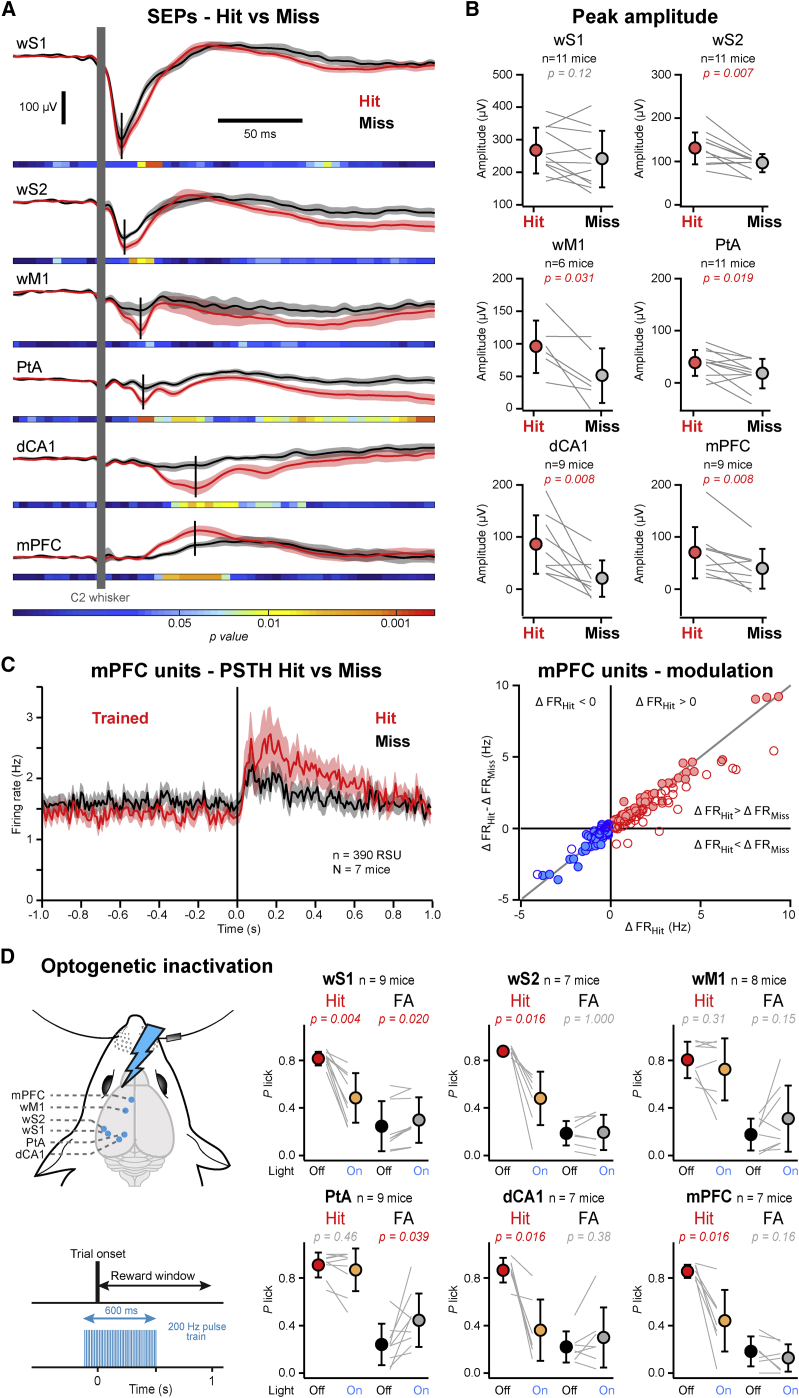
Neuronal Activity in mPFC and dCA1 Causally Contributes to Execution of the Detection Task(A) Grand average SEPs computed for Hit (red) and Miss (black) trials from mice trained in the detection task. Shaded areas indicate SEM. Horizontal bars indicate color-coded p values for statistical test of the difference between Hit and Miss trials across time (Wilcoxon signed-rank test, Hit versus Miss for 5 ms time windows). Vertical black bars indicate the times of the peak responses.(B) Comparison of the peak amplitude of the SEPs for Hit (red) and Miss (gray) trials. Circles with bars indicate mean ± SD. Gray lines represent individual mice. Red p values indicate statistically significant differences between Hit and Miss (Wilcoxon signed-rank test).(C) Left: grand average PSTHs (mean ± SEM) computed for Hit (red) and Miss (black) trials from 390 RSUs recorded in the mPFC of mice trained in the detection task (N = 7 mice). Right: scatterplot of the Hit-Miss difference in firing rate against the change in firing rate relative to prestimulus baseline in Hit trials for all significantly modulated mPFC RSUs recorded in trained mice. Red and blue circles represent positively and negatively modulated units, respectively. Filled circles indicate significant Hit-Miss difference.(D) Left: schematic drawing of the sites targeted for optogenetic inactivation on the contralateral hemisphere to the stimulated whisker in VGAT-ChR2 mice during the detection task. Right: comparison of Hit rates (red and orange) and False-Alarm rates (black and gray) computed for trials with (Light On) or without (Light Off) photo-inhibition applied to wS1, wS2, wM1, PtA, dCA1, or mPFC. Closed circles with error bars indicate mean ± SD. Gray lines indicate individual mice. Red p values indicate statistically significant differences between control trials and trials with photo-inhibition (Wilcoxon signed-rank test).